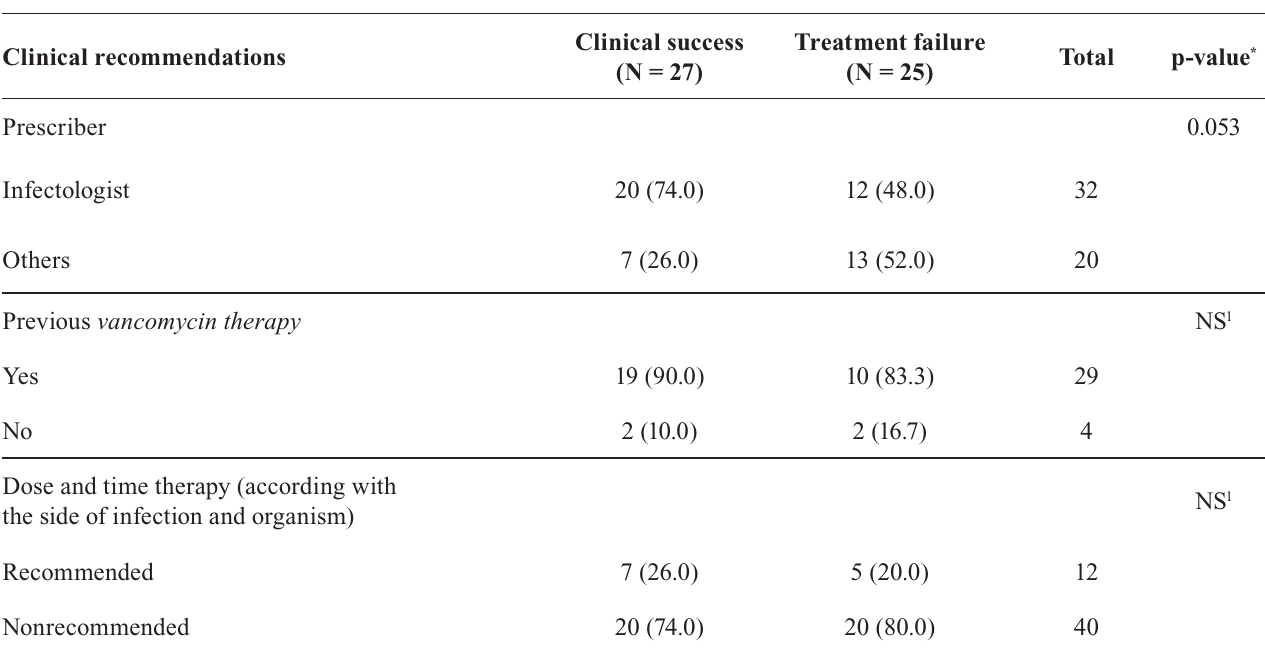
TABLE II - Adherence to different aspects of the clinical recommendations for daptomycin use and clinical success or failure among the 52 patients. Brazil,